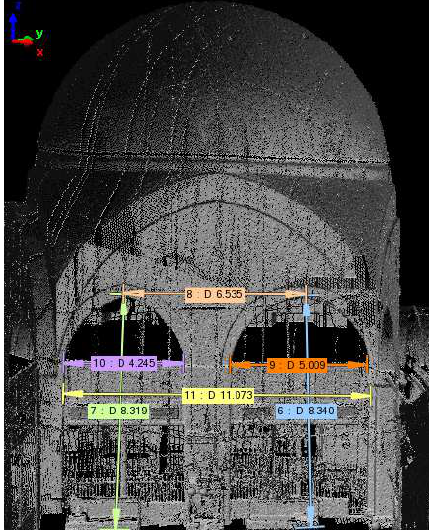
Figure 12. Dimensions from Semahane section (East side) (units are meters).